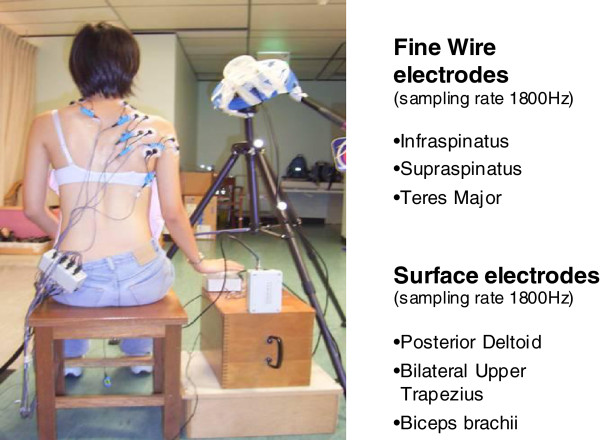
Experimental set-up.